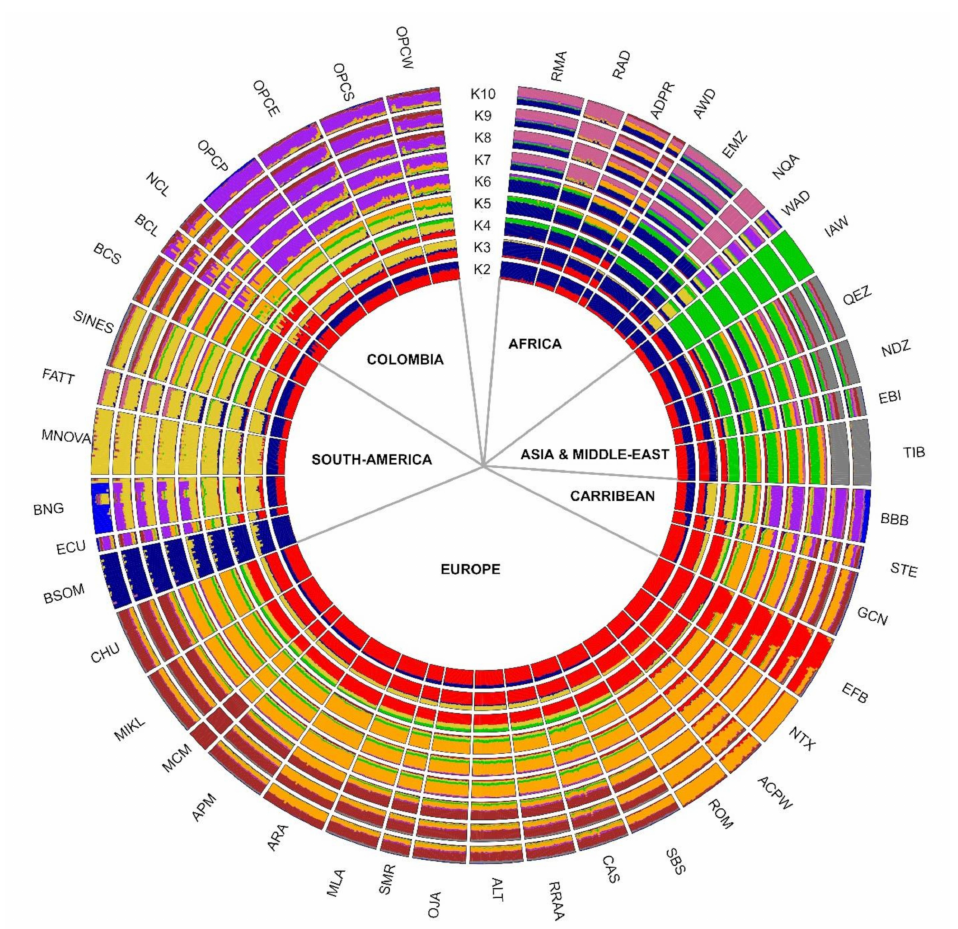
Figure 5. Clustering of 44 sheep breeds based on Admixture estimation for K = 2 to K = 10. Each bar indicated an individual and each colour the membership to a particular cluster; the number of clusters is determined by the K value. The sector inside the graphic indicated the geographical precedence of the breed: Africa, Asia and Middle-East including Egypt, the Caribbean, Europe including Oceania; South America and